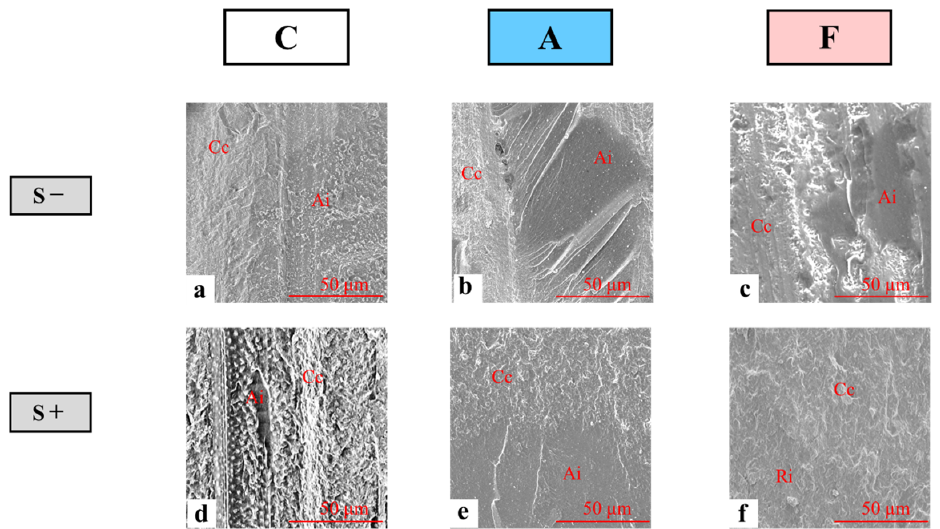
Figure 4. Representative scanning electron microscopy images of the dentin-side surface of the post- test specimens on the occlusal wall (50× magnification). Interfacial fracture occurred at the interface between the restorative and resin cement (Ri), cohesive fracture occurred within the resin cement (Cc), and interfacial fracture occurred at the interface between the resin cement and the abutment- side surface (i.e., dentin, adhesive, or flowable resin) (Ai).